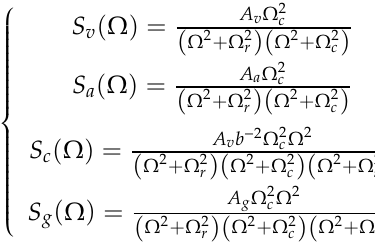
Figure 3. Model of track.